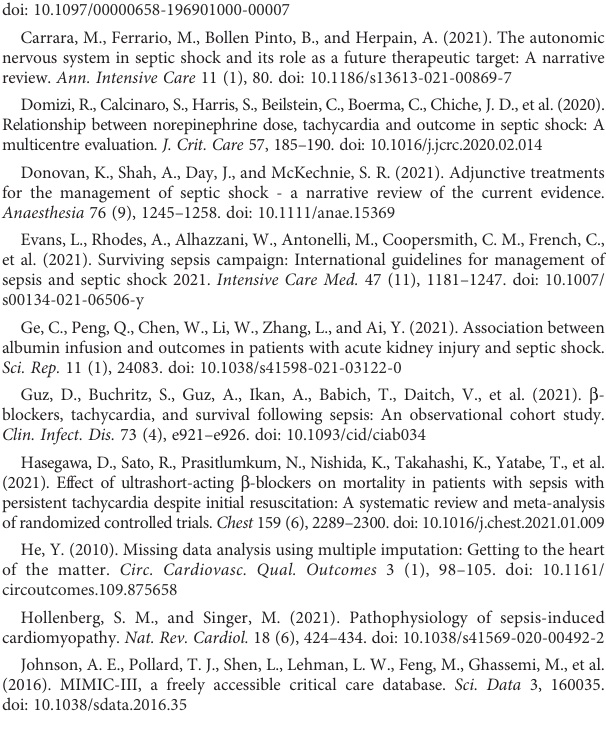
SUPPLEMENTARY FIGURE 1 Standardized mean difference of variables before and after propensity score matching (short-acting b -blockers). SMD, Standardized mean difference; MAP, mean arterial pressure; AKI, acute kidney injury; CPD, chronic pulmonary disease; SOFA, sequential organ failure assessment; RRT, renal replacement therapy. For data analysis the R package ‘ MatchIt ’ was used. SUPPLEMENTARY FIGURE 2 Standardized mean difference of variables before and after propensity score matching (long-acting b -blockers). SMD, Standardized mean difference; MAP, mean arterial pressure; AKI, acute kidney injury; CPD, chronic pulmonary disease; SOFA, sequential organ failure assessment; RRT, renal replacement therapy. For data analysis the R package ‘ MatchIt ’ was